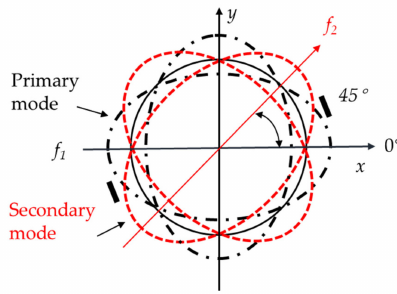
Figure 10. The resonator with two frequency axes, f 1 (cid:44) f 2 , and a method to measure the frequency split.